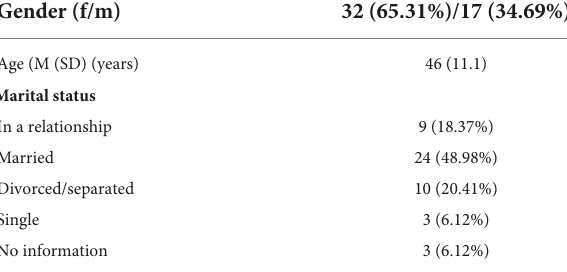
TABLE 1 Sociodemographic characteristics of the study cohort ( n = 49).